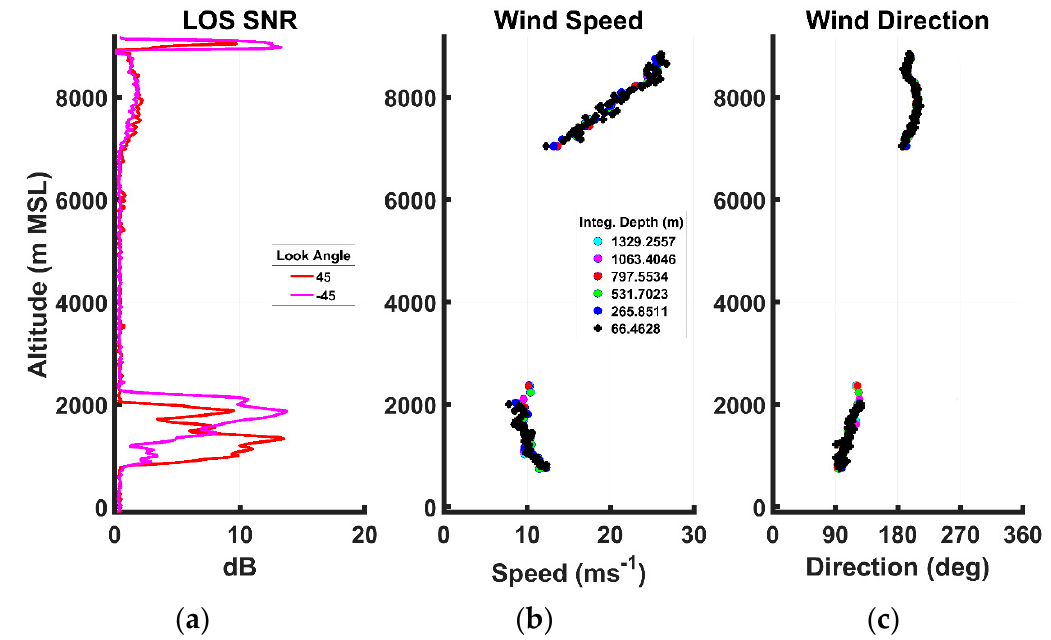
Figure 20. DAWN vertical profiles of SNR ( a ), wind speed ( b ) and wind direction ( c ) NW of the center of TS Cindy at 203740Z on 21 June 2017.